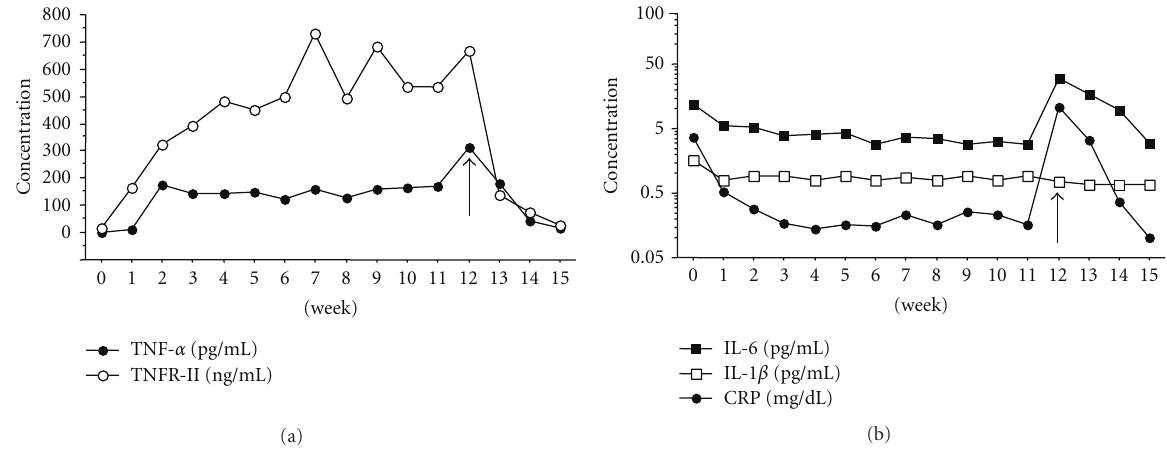
Figure 3: Time course of serum cytokines concentrations. (a) TNF- alpha concentration increased between weeks 1 and 2 after the initiation of etanercept therapy then remained steady ranging from 100pg/mL to 170 pg/mL. At 12 weeks, the patient developed PCP and the TNF- alpha value increased steeply (arrow). With cessation of etanercept, the TNF- alpha concentration immediately returned to pretreatment levels. Four weeks after the initiation of therapy, the TNFR-II concentration became steady, ranging from 300ng/mL to 700ng/mL. With cessation of etanercept due to the PCP, TNFR-II concentration returned to pretreatment levels. (b) On the other hand, at week 12, the levels of IL-6, CRP, and TNF- alpha showed an acute peak (arrow), which tapered downward over the following 3 weeks with the institution of an appropriate antifungal